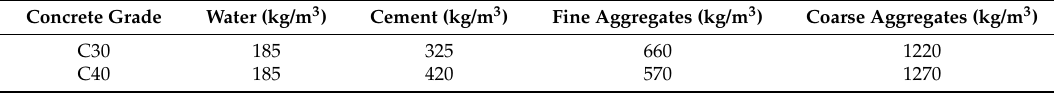
Table 2. Mix proportion of concrete.